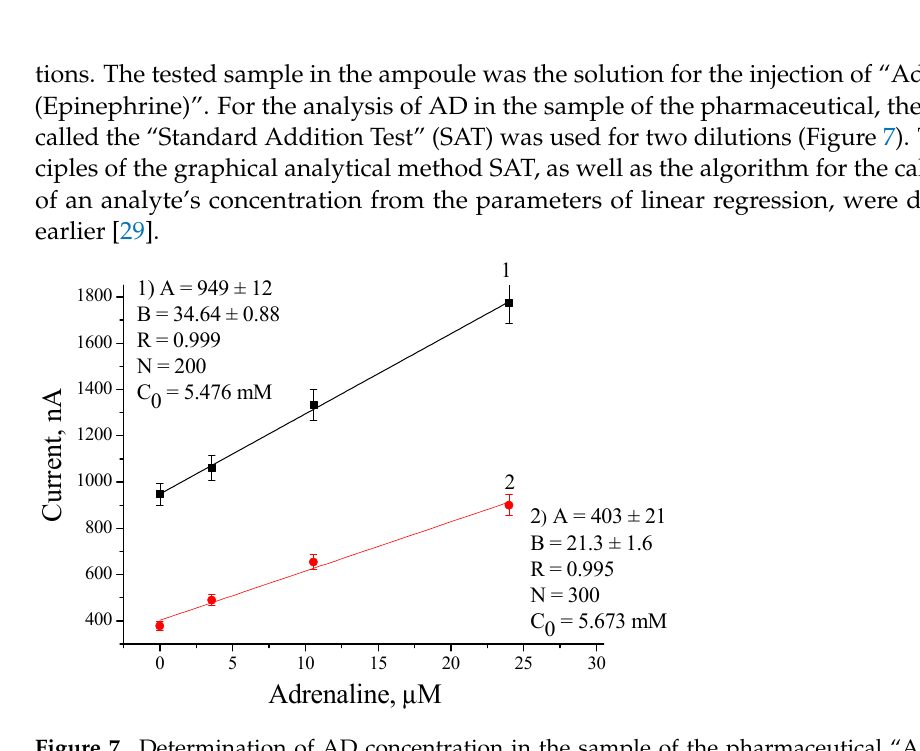
Figure 6. Selectivity for nAuCePt/GE. The test was performed with 2 mM (1) and 4 mM (2) solutions of different analytes under the working potential of − 50 mV. The amperometric signal on AD being the highest was chosen as 100%.